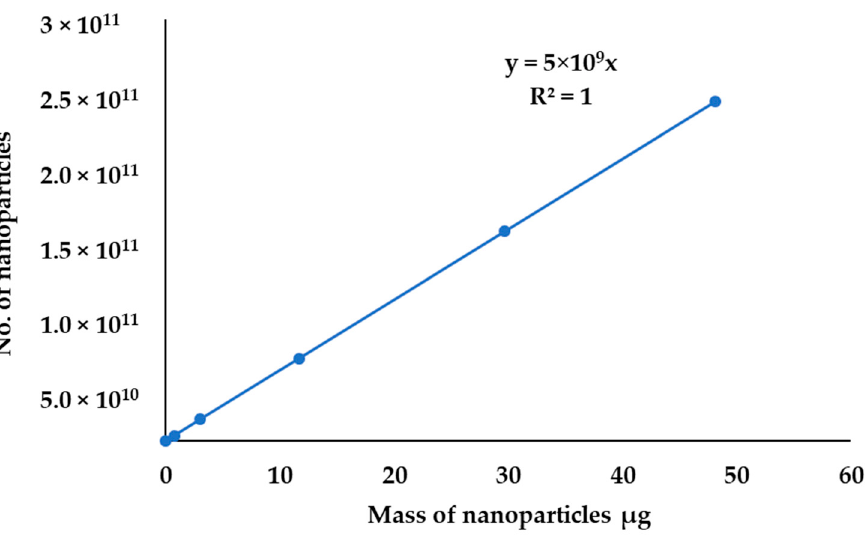
Figure 12. Linear relationship between the number of nanoparticles and the mass of the nanoparti ‐ cles .